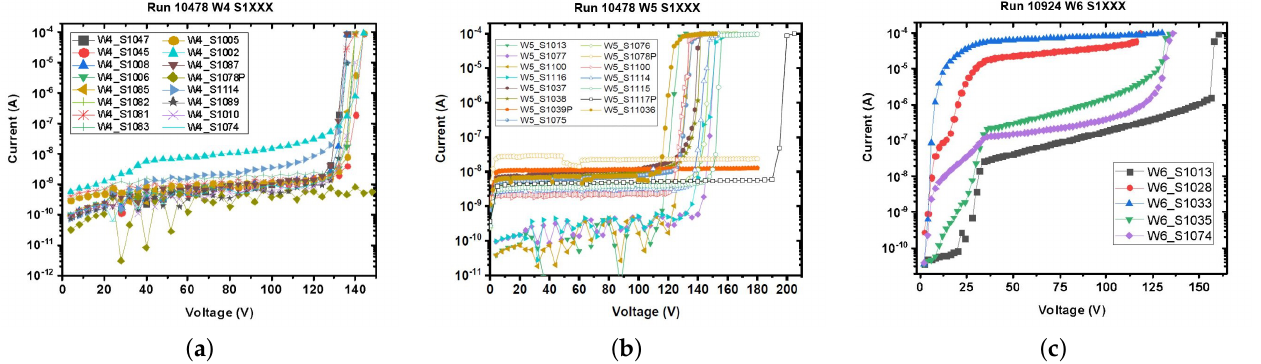
Figure A1. I-V characteristic curves for ( a ) boron, ( b ) boron plus carbon and ( c ) gallium LGADs performed at room temperature by CNM